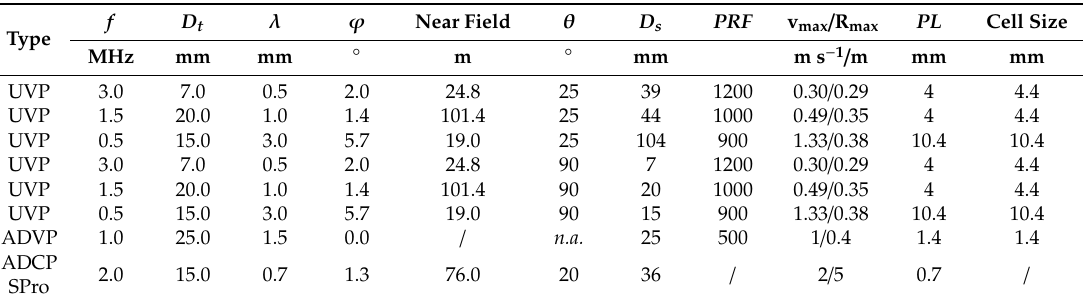
Table 2. Acoustic